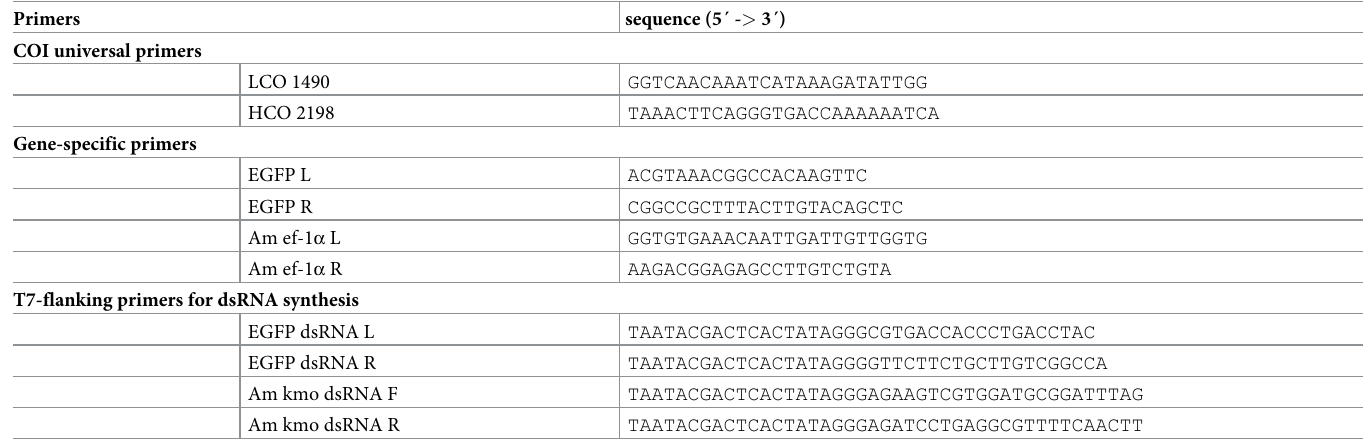
Table 1. List of